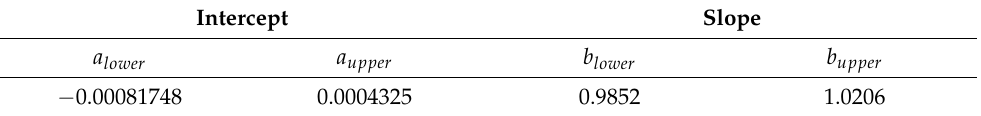
Table 5. Intercept-slope test for ANN.